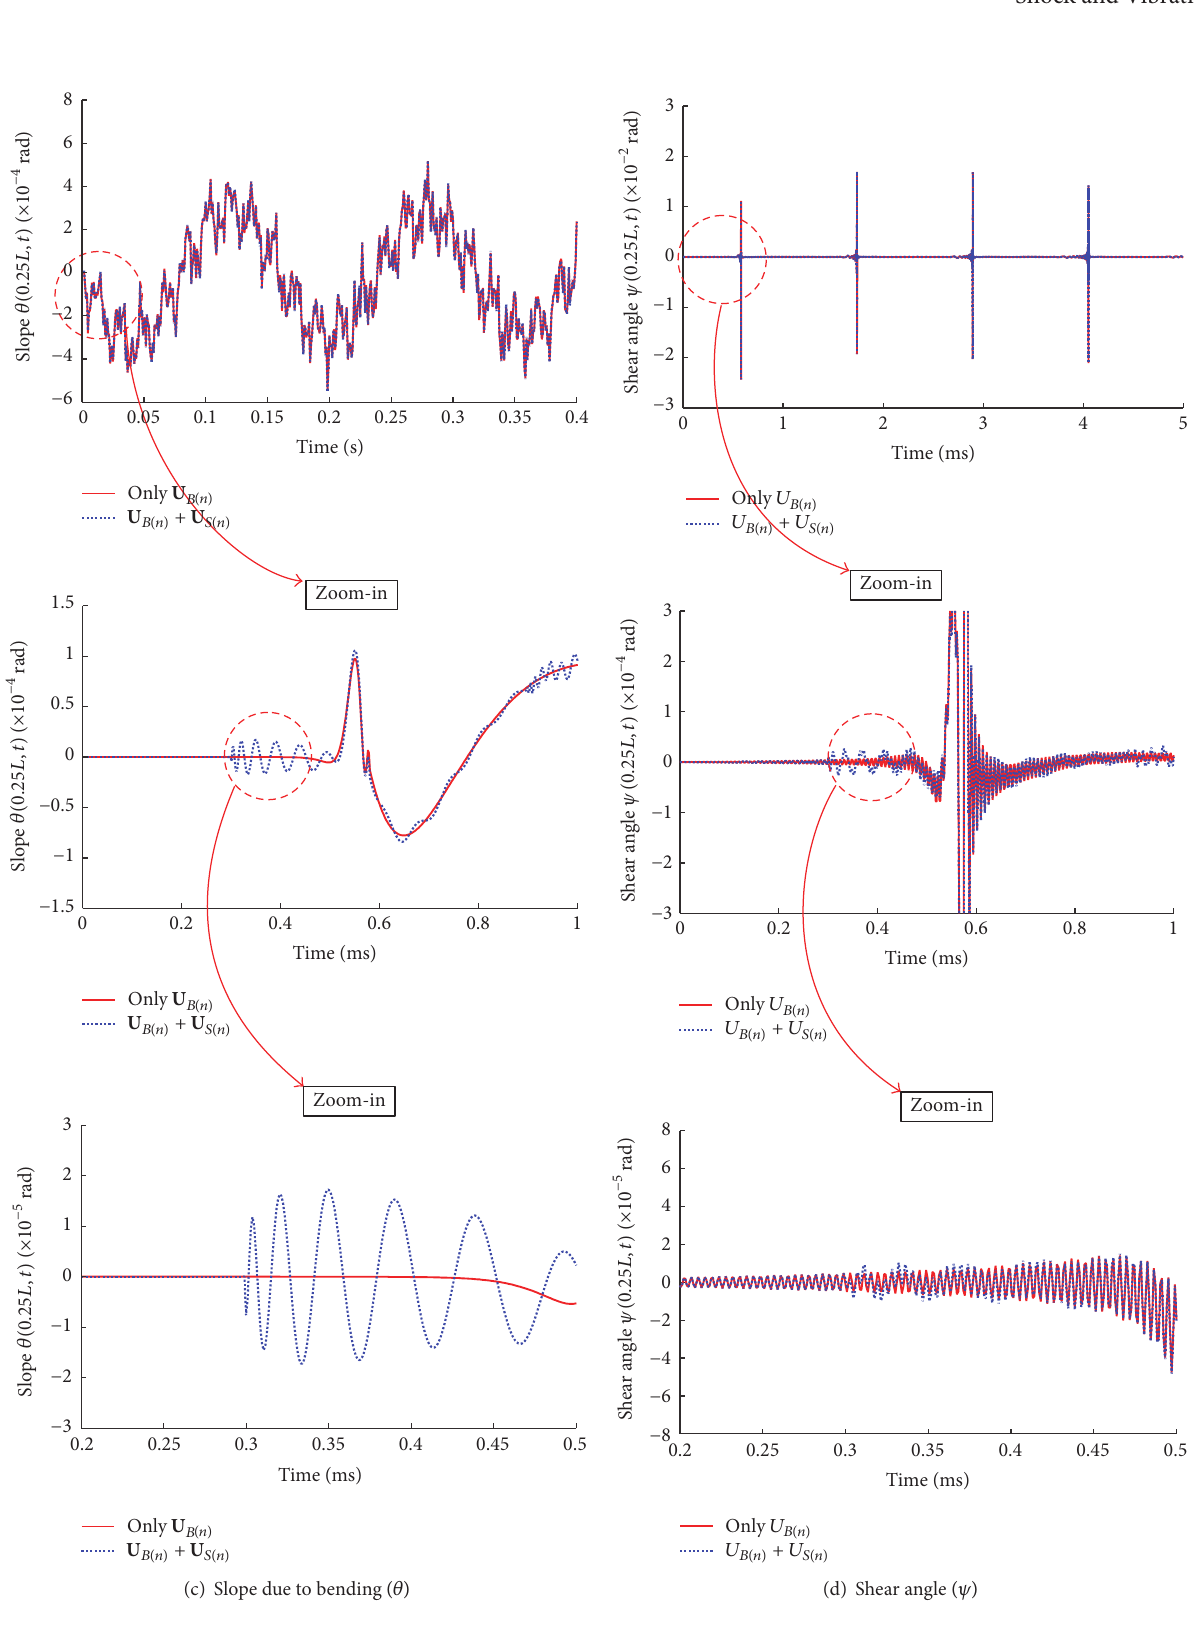
Figure 2: Dynamic responses at 𝑥/𝐿 = 0.25 of a simply supported beam subjected to a stationary impulsive point transverse force applied at 𝑥/𝐿 = 0.5 : (a) transverse displacement (𝑤) ; (b) total slope (𝑤 󸀠 ) ; (c) slope due to bending (𝜃) ; (d) shear angle (𝜓)